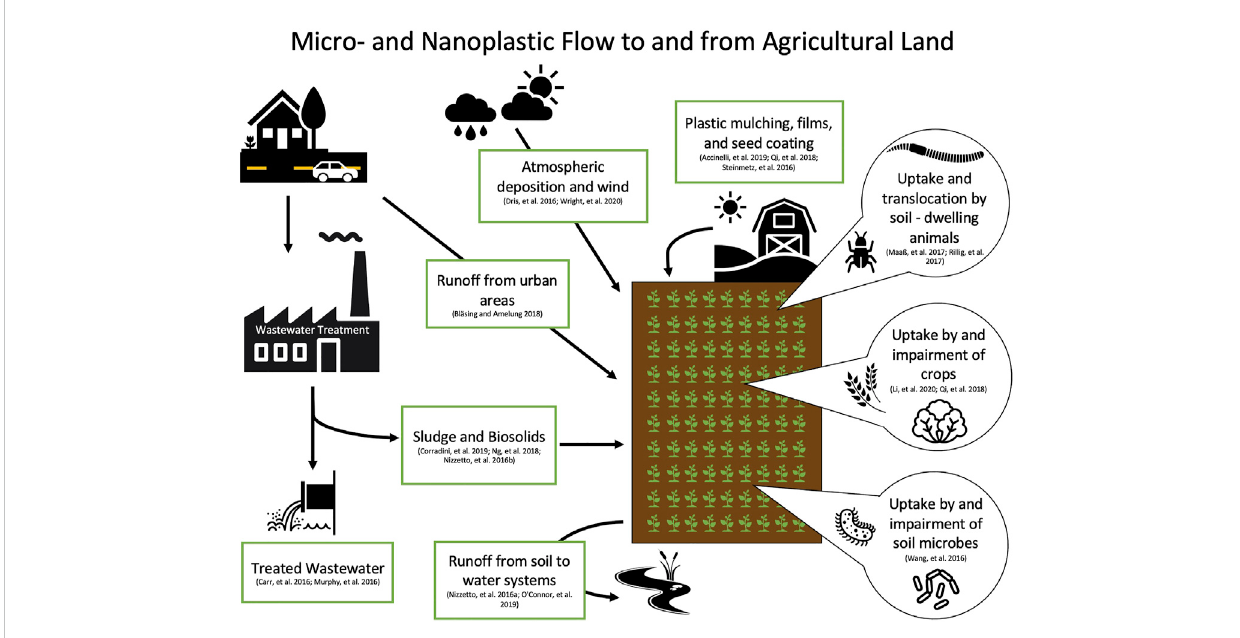
Diagram of potential sources and fl ow of micro- and nanoplastics to soil, and uptake by plants and soil-dwelling organisms (Accinelli et al., 2019; BläsingandAmelung,2018;Carretal.,2016;Corradinietal.,2019;Drisetal.,2016;Lietal.,2020a;Murphyetal.,2016;Nizzettoetal.,2016a;O'connoret al., 2019; Qi et al., 2018; Rillig et al., 2017; Steinmetz et al., 2016; Wang et al., 2016; Wright et al.,